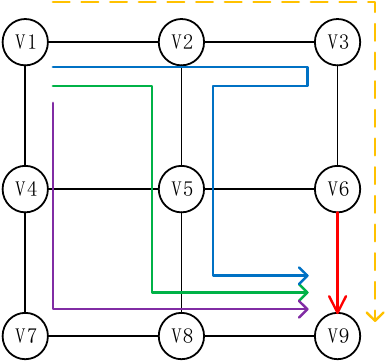
Figure 5. Comparison of strategies for different synchronization